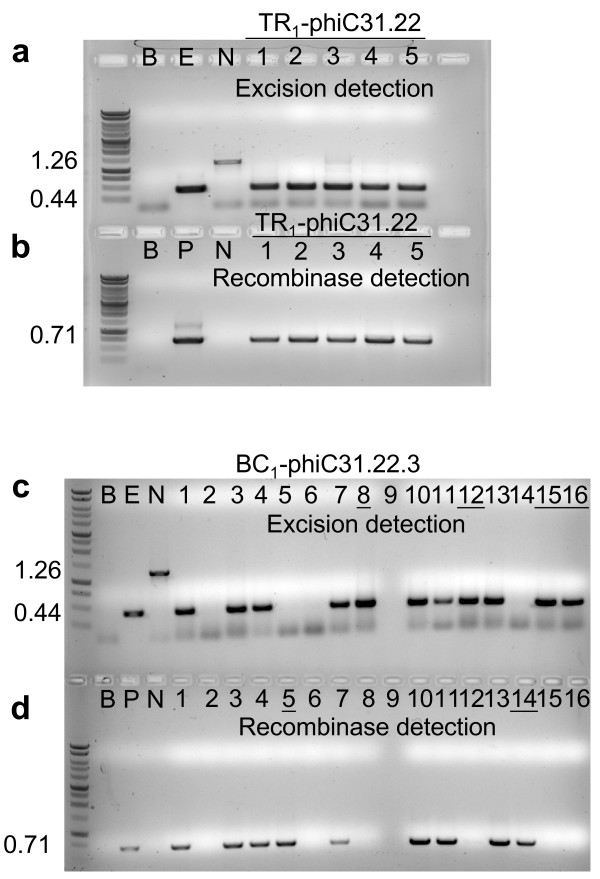
PCR analysis for site-specific recombination and the presence of the phiC31 gene in the TR1 and BC1 generations. PCR reactions (a, c) with primers e and f (Fig. 1) or (b, d) with primers g and h (Fig. 1) on representative plant DNAs. a, b) retransformed TR1- phiC31.22 lines. c, d) Back Crossed line BC1-phiC31.22.3. Unlined numbers represent excision or recombinase only plants lines. Control lanes are B (blank, no DNA); E (excision, pN3-phiC31exc); N (no excision, pN3-phiC31); P (recombinase, pCOXS3- phiC31).